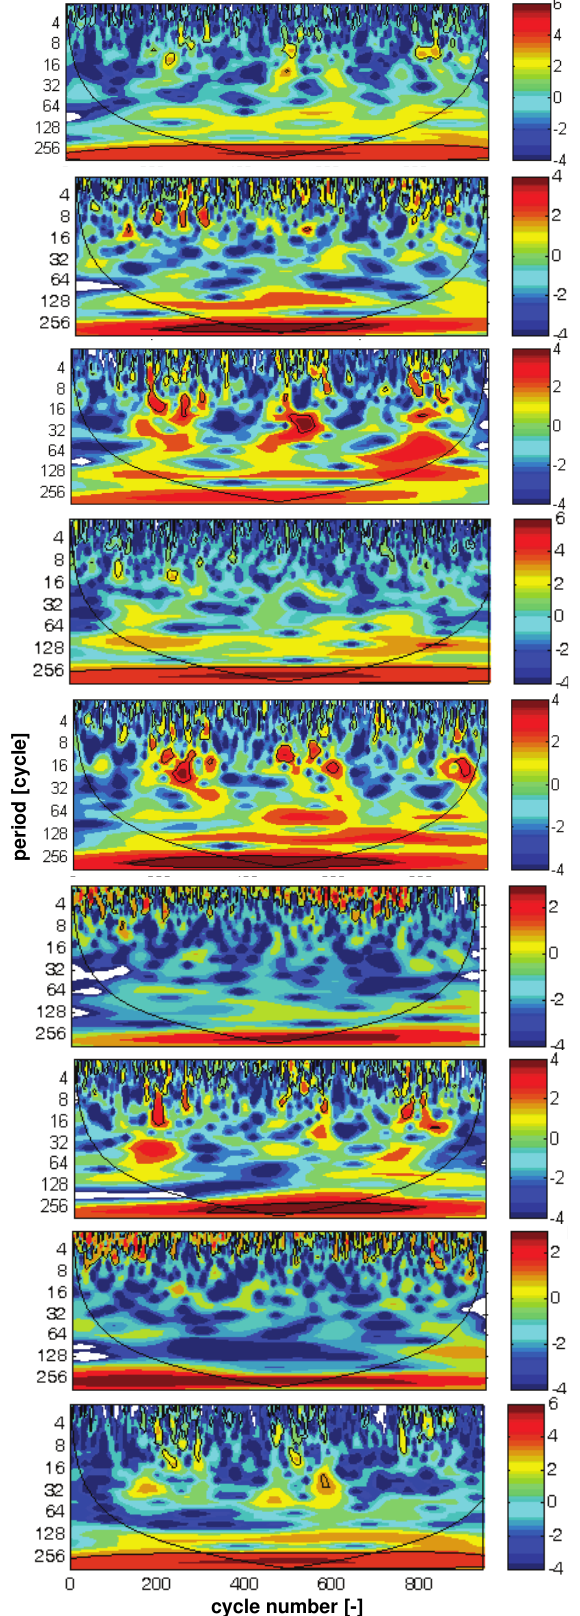
Fig. 10. Wavelet power spectrum for the IMEP in the cylinders supplied by a mixture of disturbed composition and the others supplied by a mixture of λ =